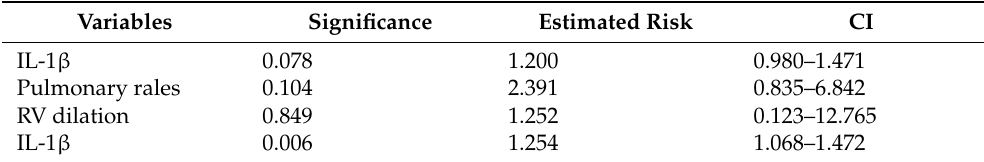
Table 5. Multivariate Cox regression